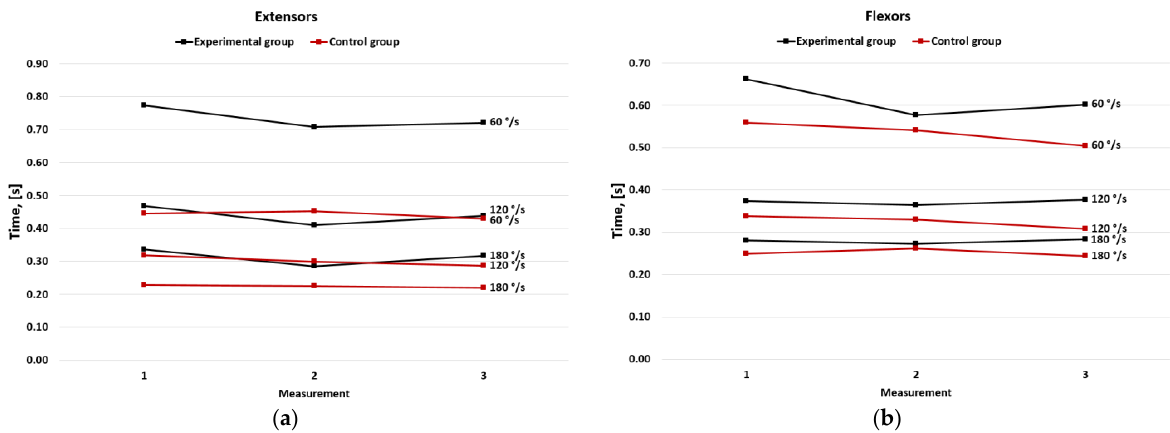
Figure 4. Mean power per body weight in the experimental and the control group for ( a ) extensors and ( b ) flexors.